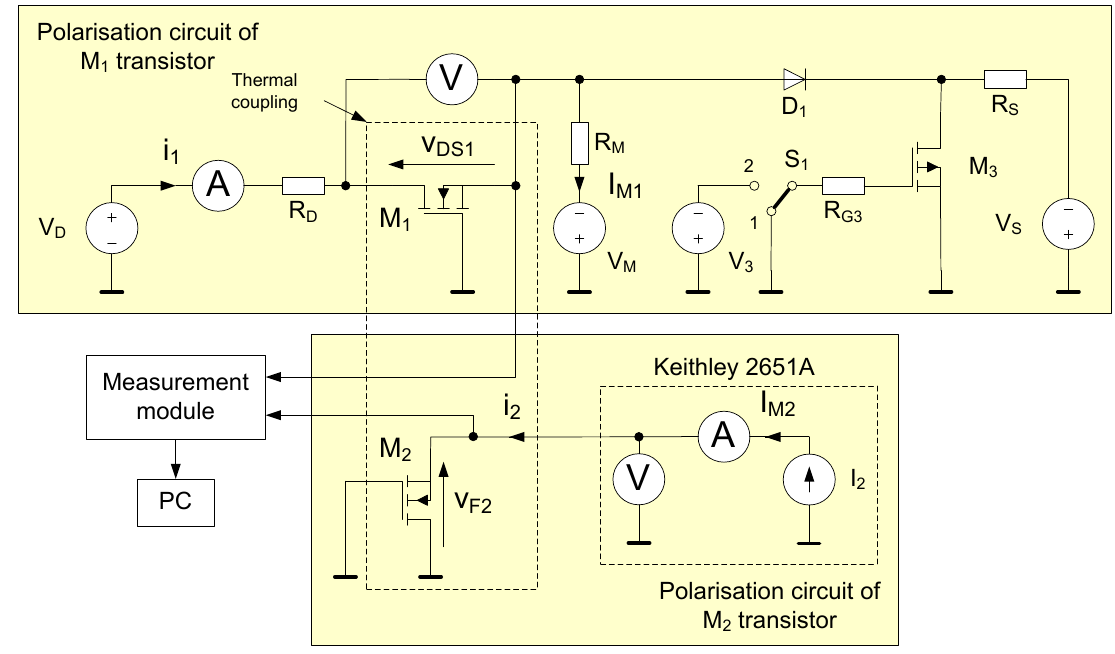
Figure 3. Diagram of the measurement setup for v GS as a TSP for M 1.